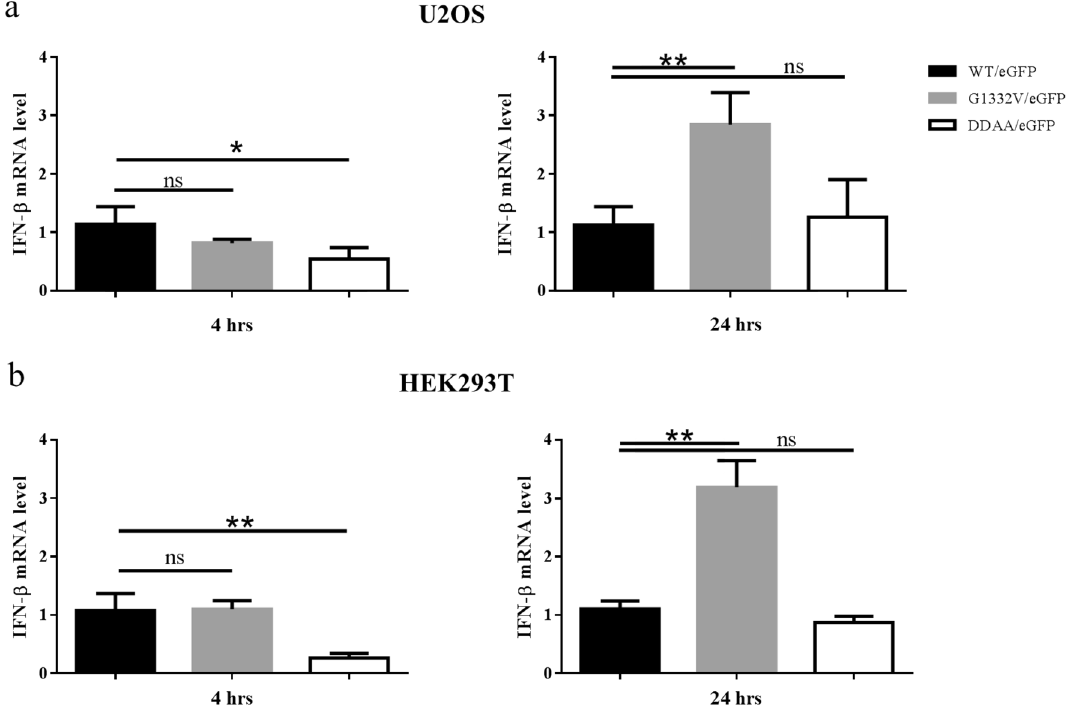
Figure 9. Induction of human IFN-β mRNA by CHIKV replicon variants. U2OS ( a ) or HEK293T ( b ) cells were transduced in triplicate using either WT/eGFP, G1332V/eGFP, or DDAA/eGFP at an MOI of 10. After incubation for 4 h (left panels) or 24 h (right panels), total RNA was harvested and subjected to qRT-PCR for quantification of IFN-β mRNA expression and normalized to HPRT. Error bars represent the standard deviation. Statistical significance was analyzed using Student’s t-test (ns, not significant; * p < 0.05 and ** p <